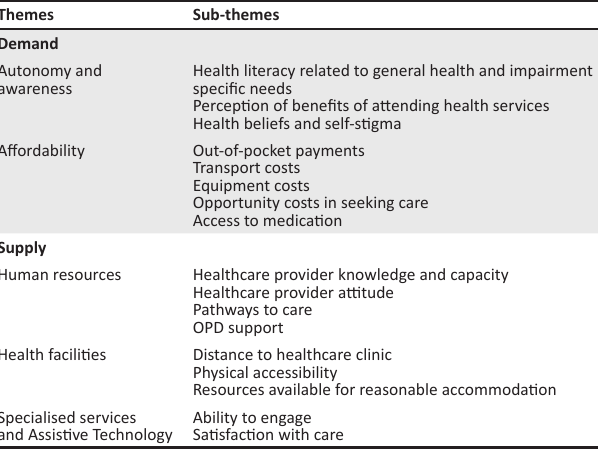
TABLE 2: Overview of